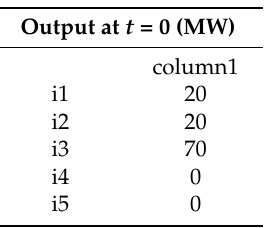
Table A14. Output power of unit i at t = 0 (MW): g_0( i ).